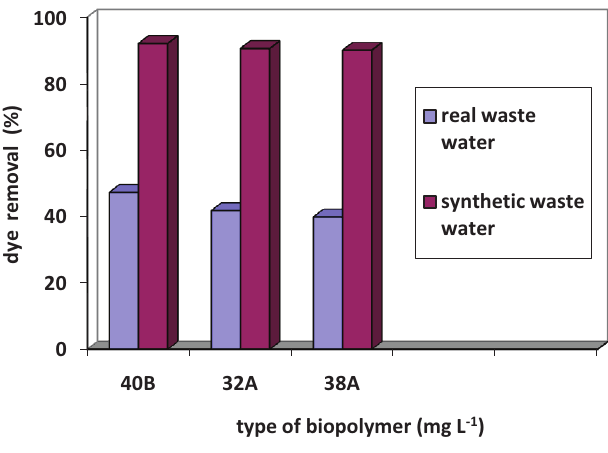
Fig. 2 – Decolourization behaviour of three biopolymers in real and synthetic wastewater